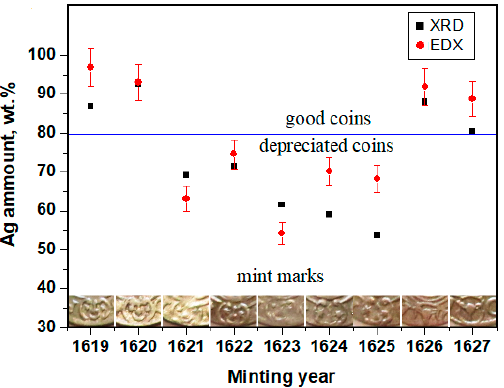
Figure 8. Silver content variation during the minting time evidenced by XRD and SEM-EDS compared with the aspect of the mint marks.